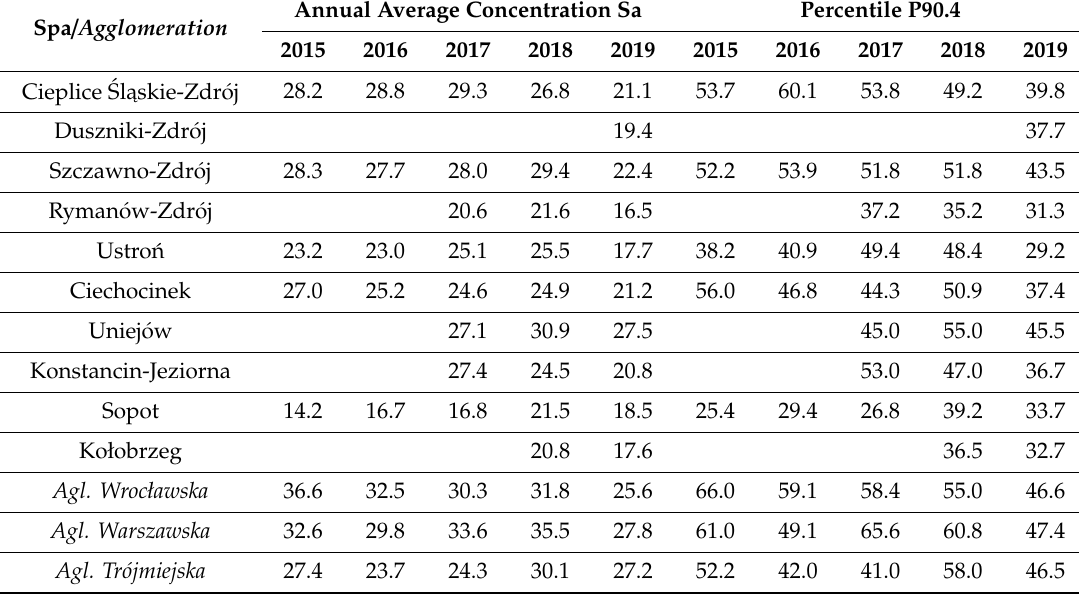
Table 3. Annual average PM 10 concentrations (Sa) and 90.4 percentile * for the examined health resorts and agglomerations in